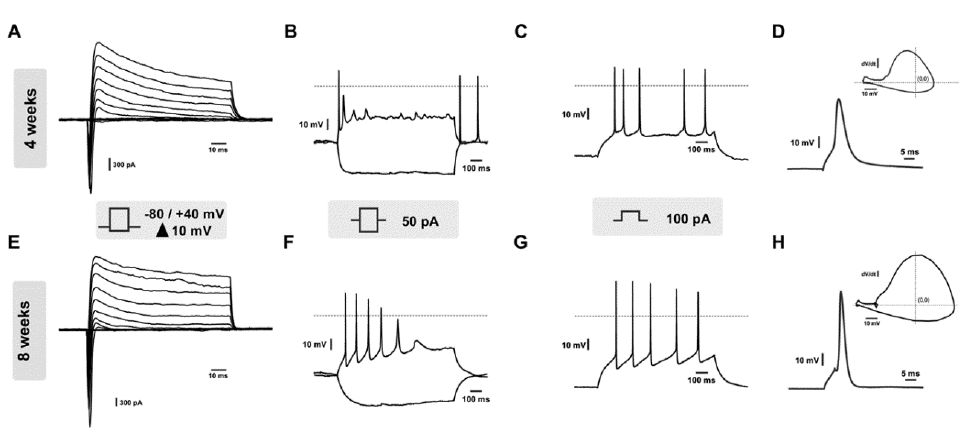
Figure 5. Functional electrical activity of hiPSC-derived MNs. ( A , E ) Representative voltage-gated ion current traces elicited during the stimulation through 10 mV voltage steps as shown in the stimulation protocol (middle box). ( B , F ) Active membrane responses to hyperpolarizing ( − 50 pA) and depolarizing (50 pA) current injection (1 s). ( C , G ) Examples of firing characteristics in 4- and 8-weeks mature cultures as response to 100 pA/1 s current injections. ( D , H ) Representative recordings of single AP elicited upon brief (10 ms) current pulse. Inset: phase plots (dV/dt versus membrane voltage) constructed from example records. For the whole figure, the upper and lower panels represent 4-weeks and 8-weeks of maturation, respectively.